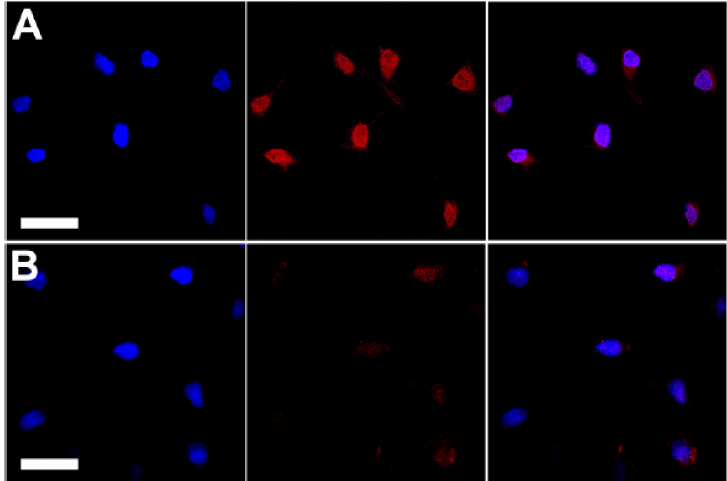
Figure 7. Confocal fluorescence images of SKOV-3 cells labeled by Pdot-folate conjugates (based on CP 36 ) and the flow cytometry results using MCF-7 cells. ( A ) The blue fluorescence results from the nuclear counterstain Hoechst 34580, and the red fluorescence is due to the Pdot–folate conjugates. The right panel shows the overlay of the blue and red fluorescence; ( B ) images of negative control samples in which cells were incubated with bare Pdots without folate functionalization. The scale bars are 30 µ m. Reproduced with permission [44]. Copyright: 2015, American Chemical